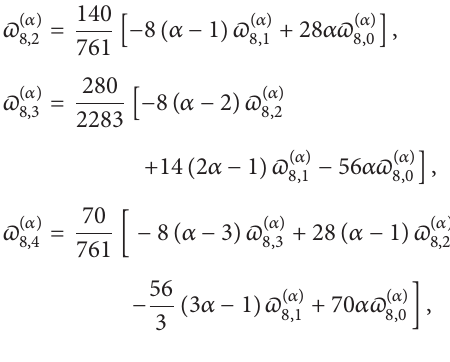
Figure 11: The exact value of 𝑝 = 9 for 𝛼 = 0.5 and step length of ℎ = 1/120 .